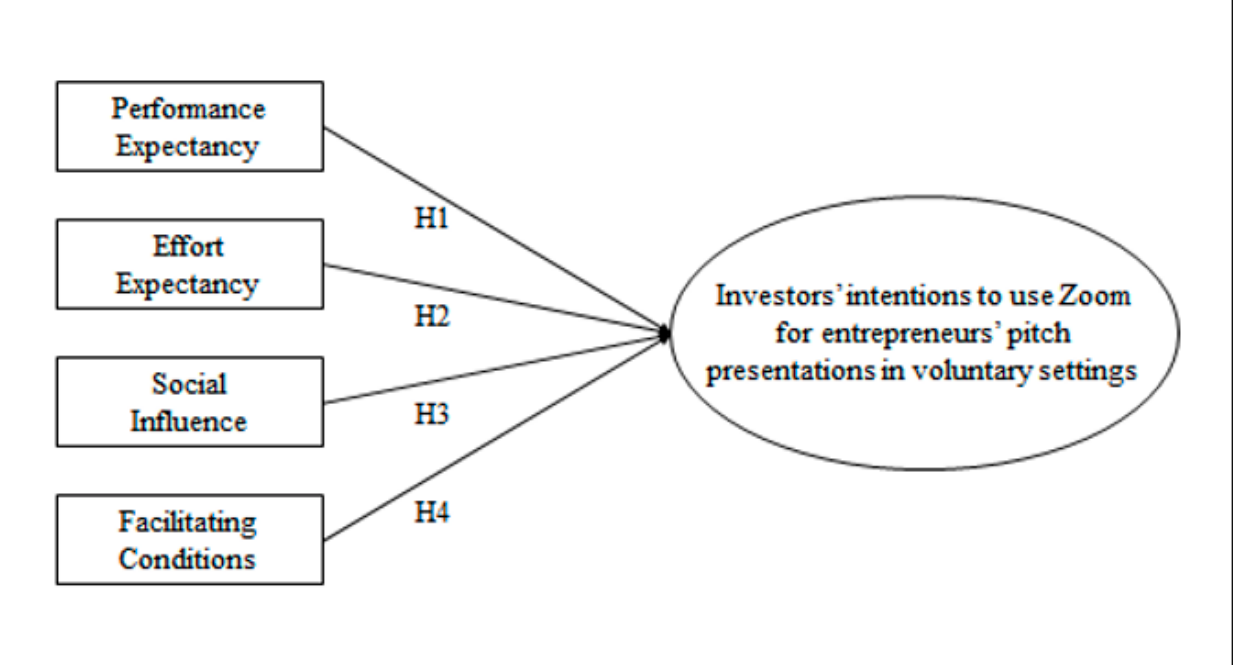
Figure 1. Hypotheses of the present study.